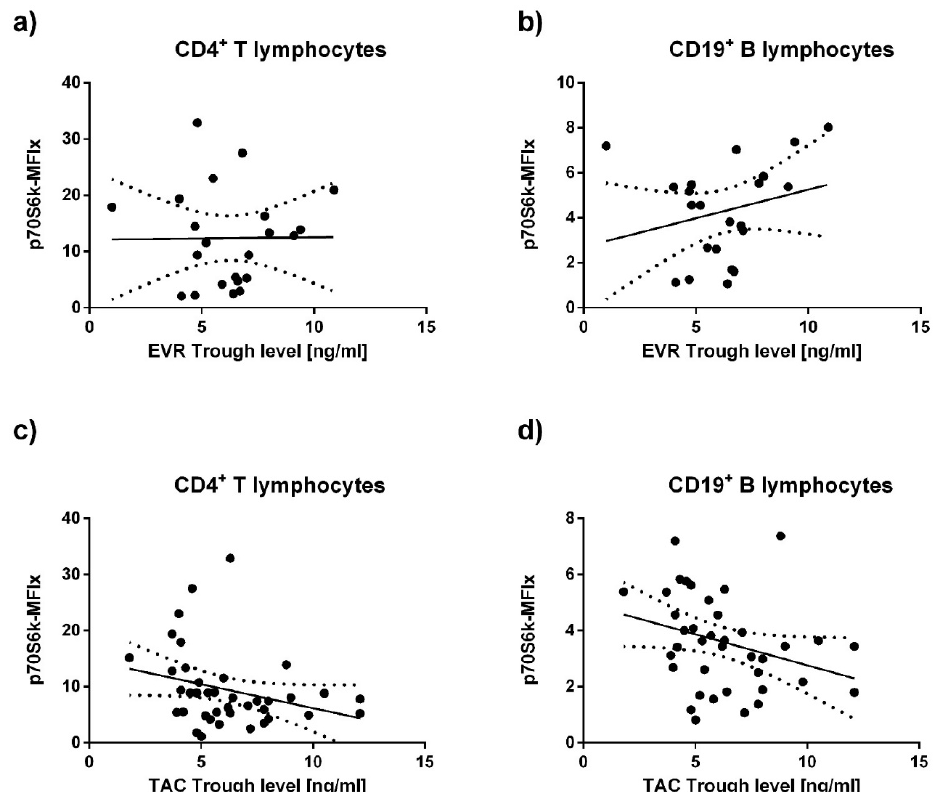
Figure 3. Tacrolimus but not Everolimus trough levels correlate with p70S6k phosphorylation. EVR trough levels at the day of measurement were not significantly correlated with p70S6k phosphorylation as measured in ( a ) CD4 + T lymphocytes (Spearman r = 0.1011, p = 0.3271) and ( b ) CD19 + B lymphocytes (Spearman r = 0.3384, p = 0.0617). TAC trough levels and p70S6k phosphorylation were found to negatively correlate when analyzing all patients of the cohort receiving TAC in both ( c ) CD4 + T lymphocytes (Spearman r = − 0.3779, p = 0.0089) and ( d ) CD19 + B lymphocytes (Spearman r = − 0.3689, p = 0.0104). Spearman’s rank test was used to determine statistical correlation.